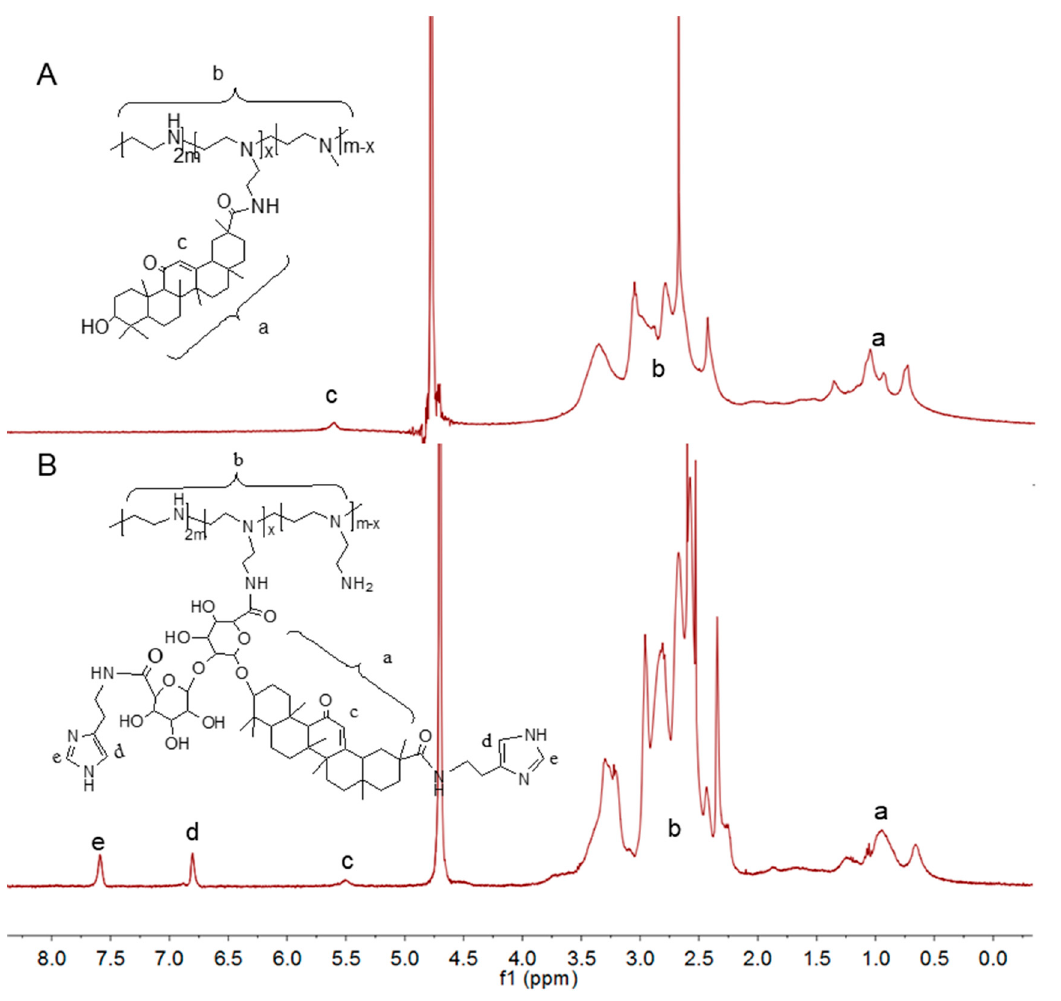
Figure 1. Characterization of and glycyrrhetinic acid (GA) or glycyrrhizin acid (GL) modified PEIs. ( A ) 1H-NMR of polyethyleneimine (PEI)-GA 1.7 , ( B ) PEI-GL2 0.65 . ( C ) UV absorbance of PEI-GA 0.75 (0.1 mg/mL), PEI-GL1 0.62 (0.15 mg/mL) and PEI1.8K (0.384 mg/mL). Table 1. Amount substitution of PEI-GA and PEI-GL. Item Feed Ratio Substitution Amount Yield (by